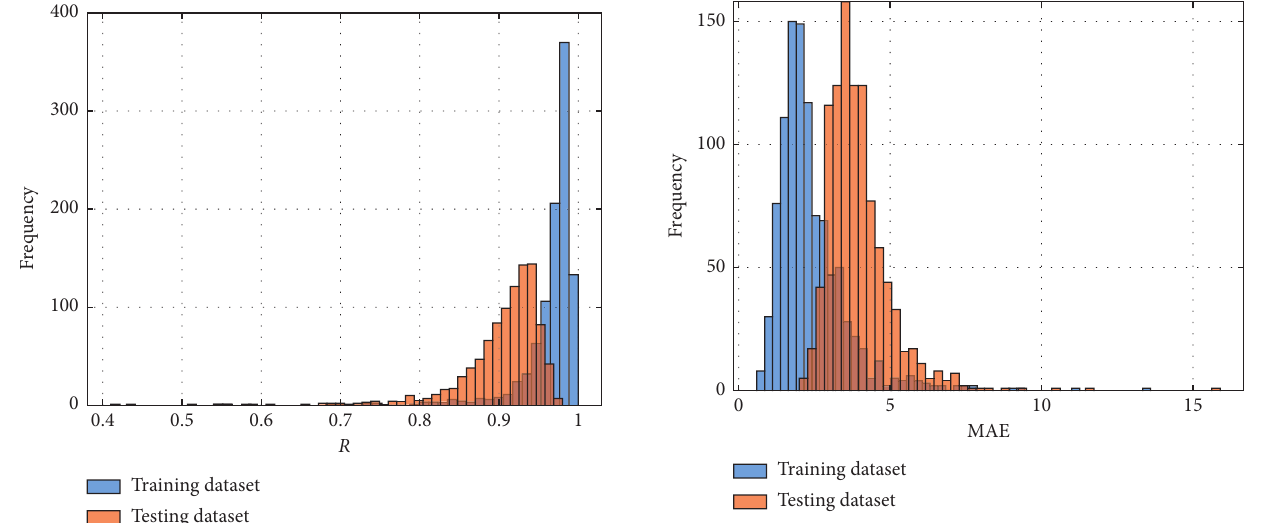
Figure 4: Histogram of MAE values over 1000 simulations for the training and testing parts. Table 3: Statistical results over 1000 simulations using FNN in this study.